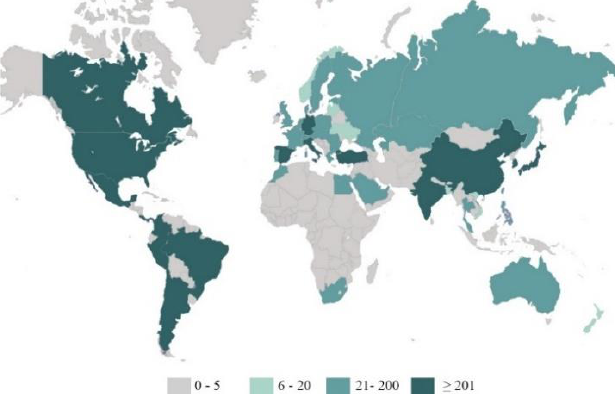
Fig. 3. Countries with LEED certificates in the world and the number range [Created by the authors based on LEED data]